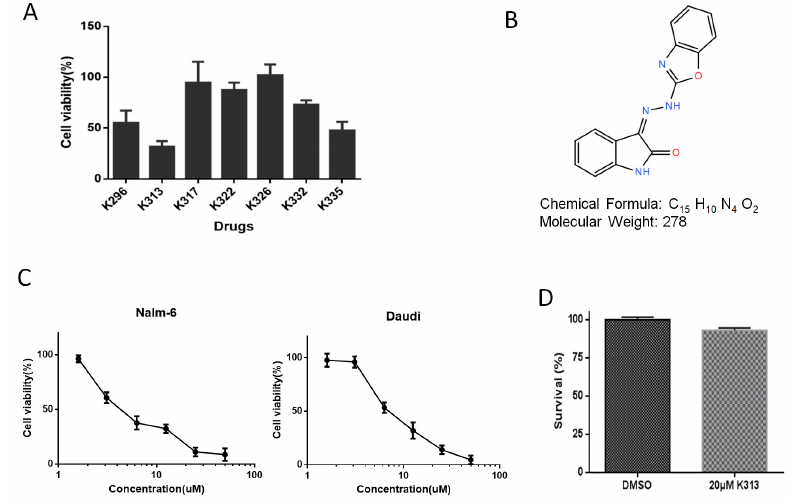
Figure 1. K313 reduces the viability of Nalm-6 and Daudi cells in vitro. ( A ) The cytotoxicity of several drugs were simply tested in a single concentration (10 µ M) by treating Nalm-6 cells for 48 h. ( B ) Chemical structure of K313. ( C ) Nalm-6 and Daudi cells were treated with different concentrations (1.6, 3.1, 6.3, 12.5, 25.0, 50.0 µ M) of K313 for 48 h. The viability of the Nalm-6 and Daudi cells decreased in a dose-dependent manner. ( D ) Survival of PBMCs after incubation with 20 µ M K313 for 48 h. Cells were stained with 7-aminoactinomycine-D (7-AAD) and analyzed using a flow cytometer. 0.5% dimethyl sulfoxide (DMSO) treated control cells represent 100%